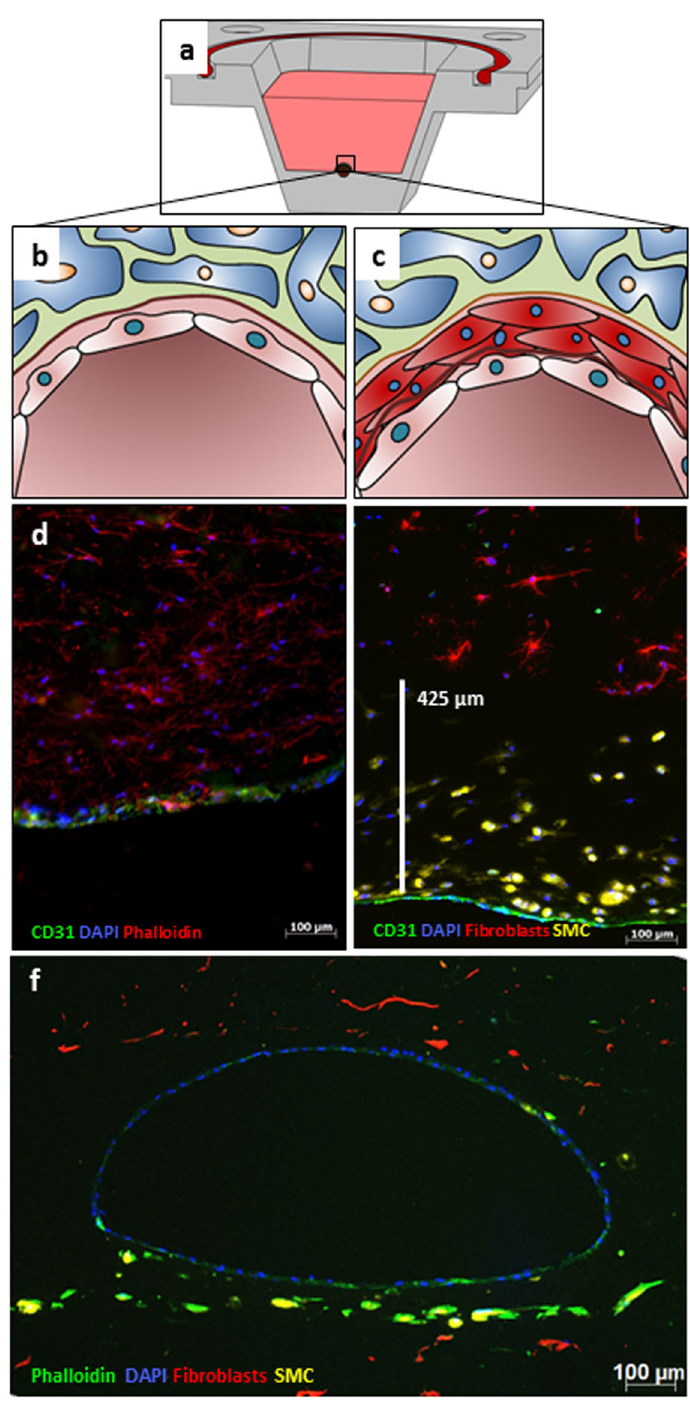
Figure 5. Fluorescence micrographs of vascular-like channels in cross section. Schematic cross section of a reactor shows a single channel ( a ). Schematic cross section of the channel in close-up shows a single layer of endothelial cells (EC) ( b ) and an additional SMC layer ( c ). Confluent layer of EC at the channel wall after 14 days of flow in cross section ( d ) (CD31 in green, Actin-phalloidin in red, DAPI in blue, 10x). Combination of SMC layer and the EC layer showing the distribution of SMCs close to the intact channel as a cross section after 7 days of flow ( e ) (CD31 in green, prelabelled fibroblasts in red, prelabelled SMCs in yellow, DAPI in blue, 20x). A representative fluorescence microscopy image in cross-section highlights the whole architecture of a multi-layered vessel model after 4 days of dynamic cultivation; EC are homogenously distributed in the inner part of the lumen, surrounded by fibroblasts and SMCs. ( f ) (Phalloidin in green, prelabelled fibroblasts in red, prelabelled SMCs in yellow, DAPI in blue,